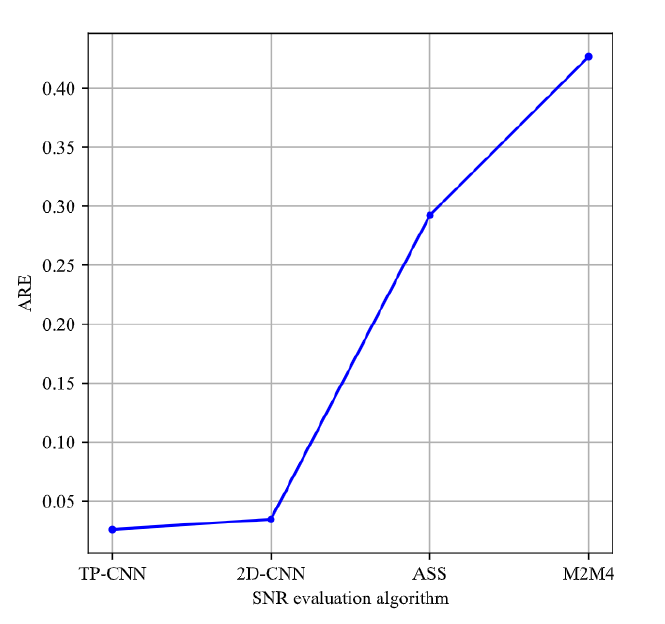
Figure 11. Average relative error of the four algorithms for SNR